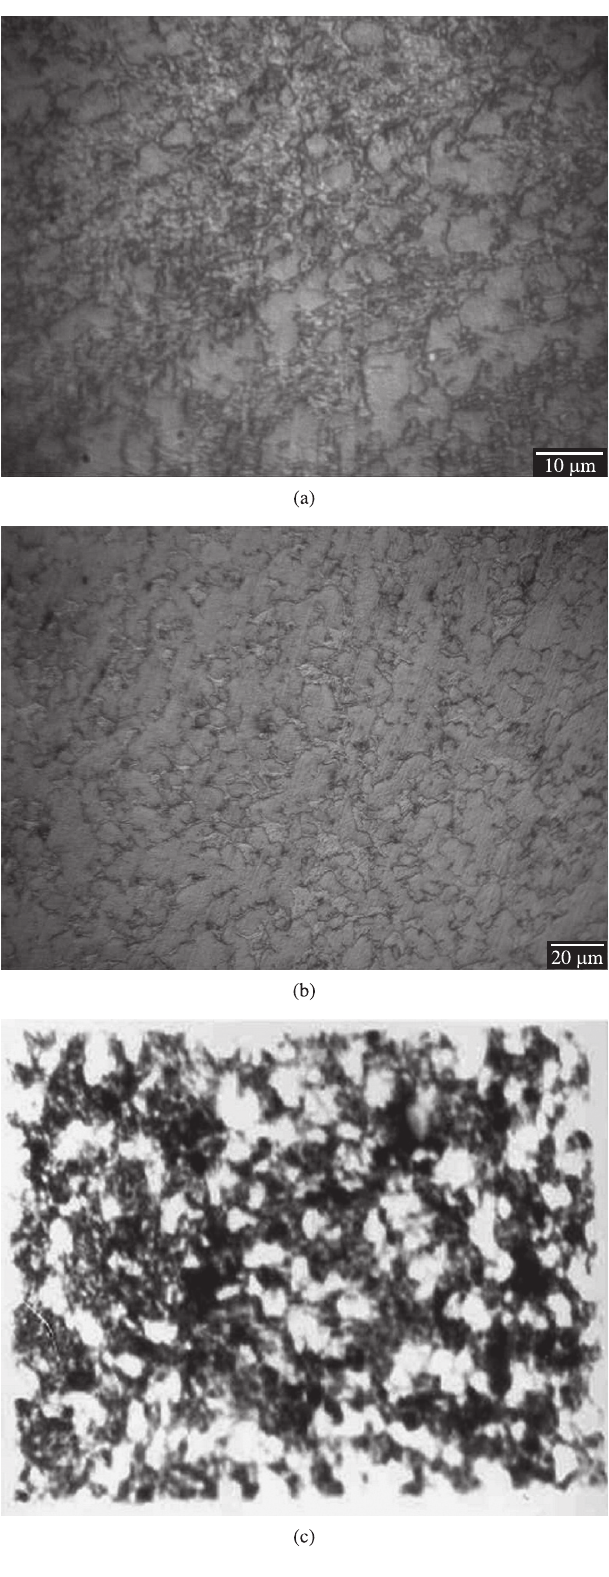
Figure 6. a) The microstructure of M300/70%/760 °C, 30 min/H O. The structure 2 reveals secondary recrystallized grains of ferrite with fine cementite particles; b) The microstructure of M500/70%/760 °C, 30 min/H O. The structure reveals large 2 dispersion of secondary recrystallized grains of ferrite; and c) The microstructure of M650/70%/760 °C, 30 min/H O. The structure reveals well defined duplex 2 microstructure of ferrite (white phase) and martensite (dark